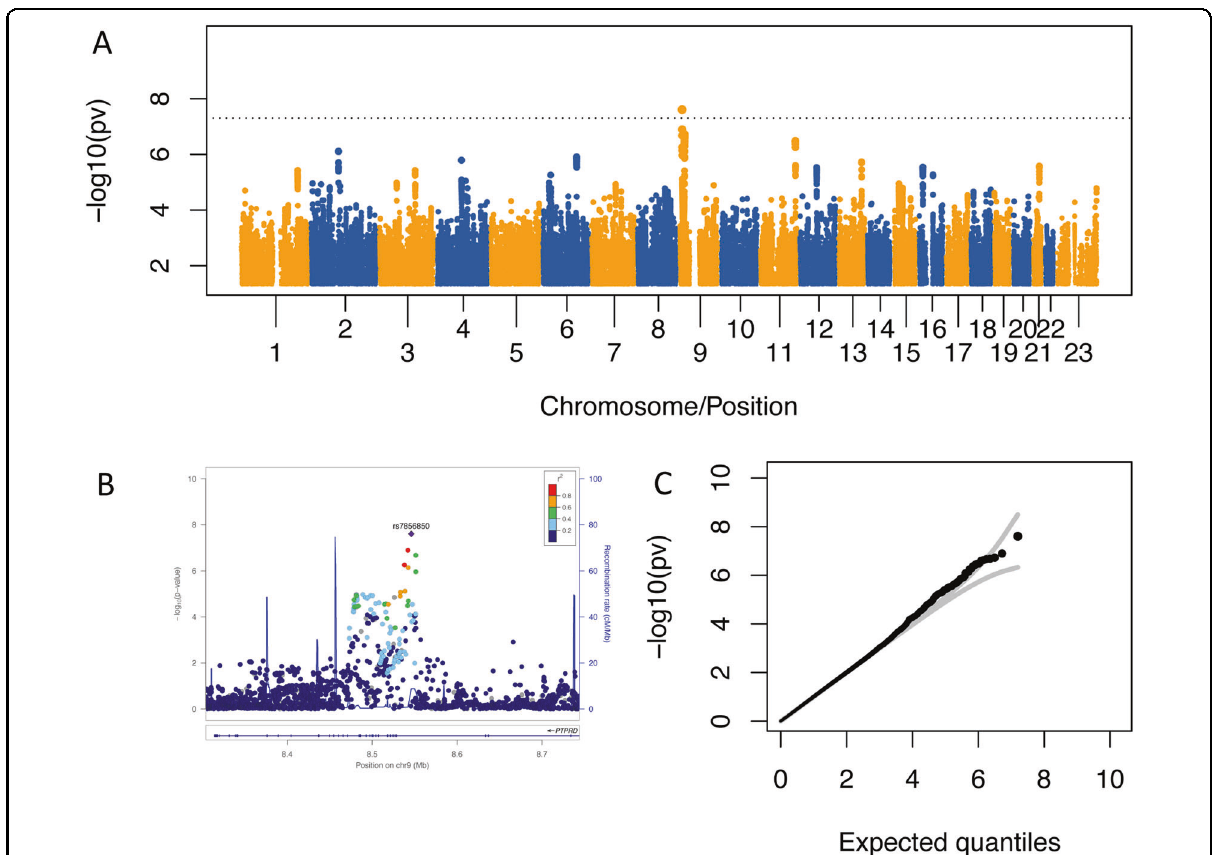
Fig. 2 Genome-wide signi fi cant locus in PTPRD associated with OC traits in Spit for Science. A Manhattan plot for GWAS of the TOCS standardized total score. rs7856850 in one of the introns of PTPRD surpassed the genome-wide threshold ( p = 5 × 10 − 8 ; gray line). B Locus zoom plot for the genome-wide signi fi cant locus from the GWAS of the TOCS standardized total score. C QQ Plot for the GWAS of the TOCS standardized total score. n = 5018.